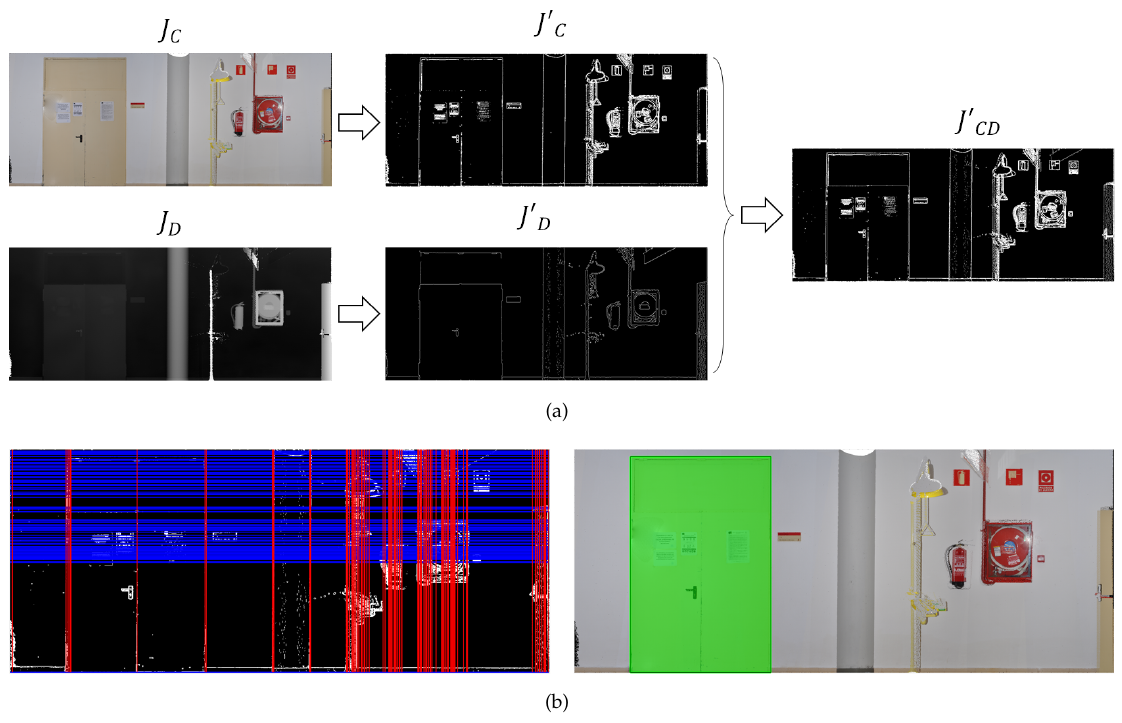
Figure 4. ( a ) Orthoimage J CD separated into colour and depth components, and the combined discontinuity image J (cid:48) . ( b ) Horizontal and vertical lines detected and the recognized door CD (highlighted in